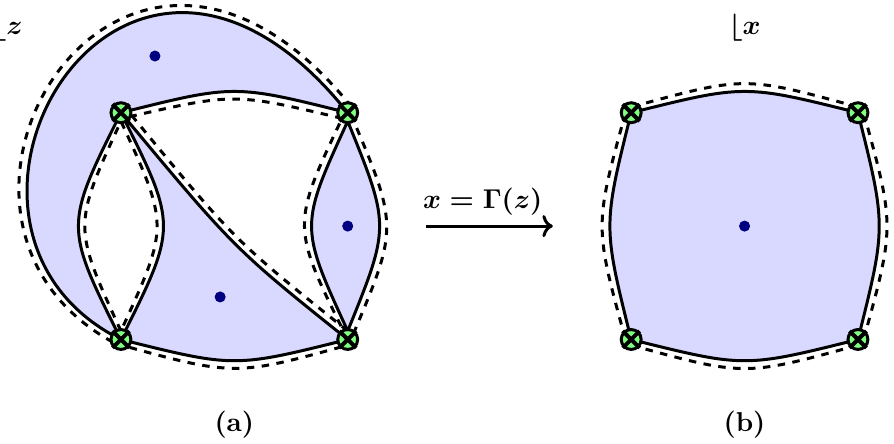
Figure 6 . Feynman graph of a symmetric orbifold correlator, formed by the preimage of a Jordan curve under Γ . Here n = 4 , w i = 2 and so N = 3 . Figure taken from [11].